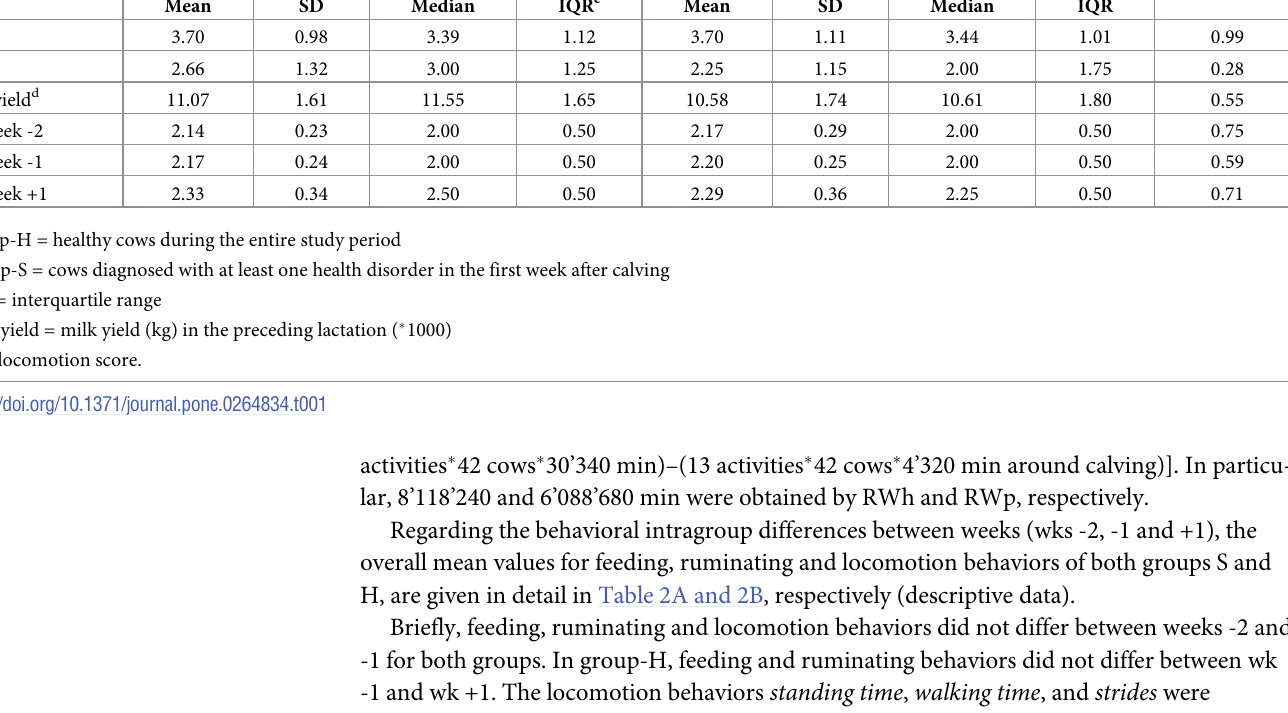
Table 2a. Mean values of variables of RumiWatch 1 halters and pedometers of group-H cows at week -2, -1 and +1. Variables Halter Other activity time (min/24 hrs) Ruminate time (min/24